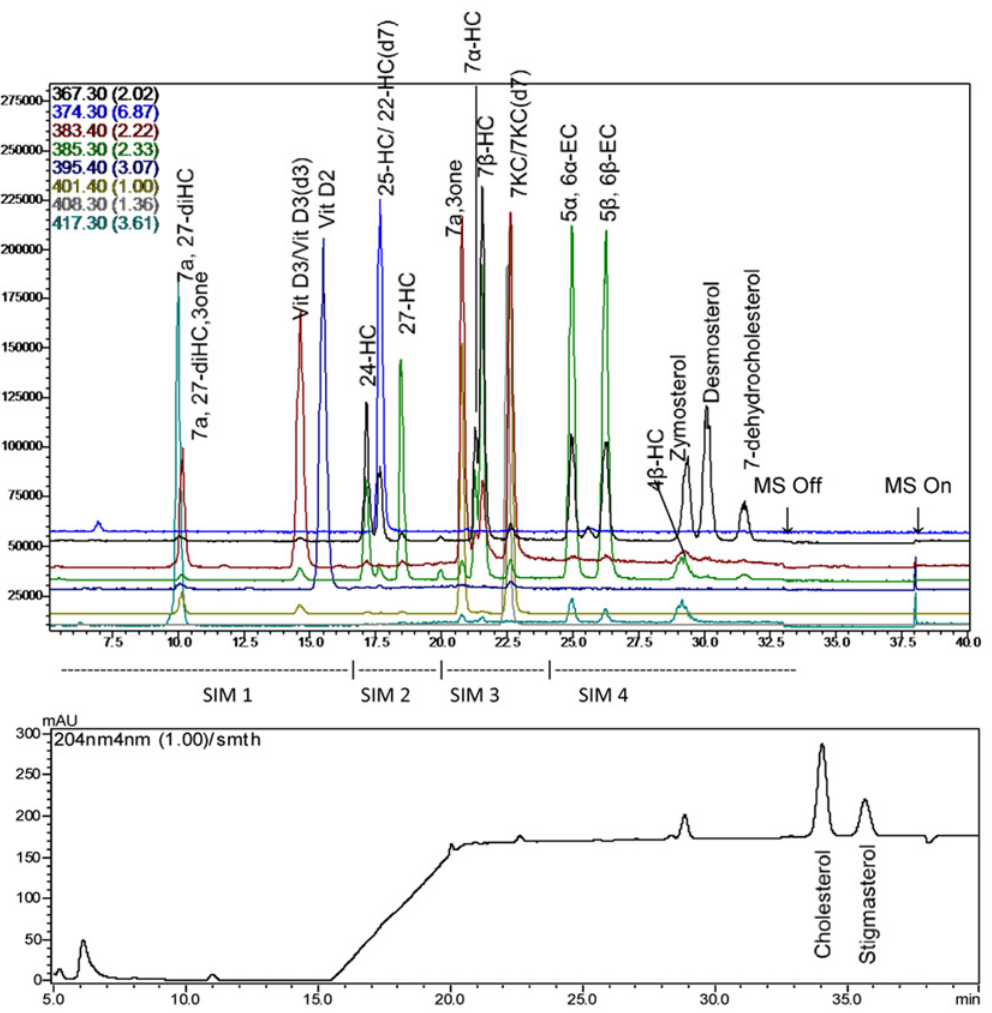
Fig 1. LC-MS-PDA chromatogram of standards. The top panel shows the chromatogram of each selected ion-monitoring (SIM) channel with each analyte identified at the peak apex. MS Off/MS On indicated the activation points for the flow control valve. The bottom panel shows the PDA Chromatogram at 204